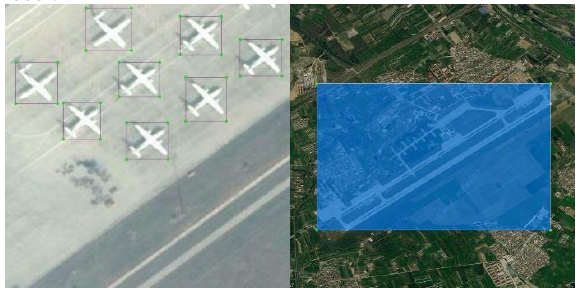
Figure 5. Demo of image label